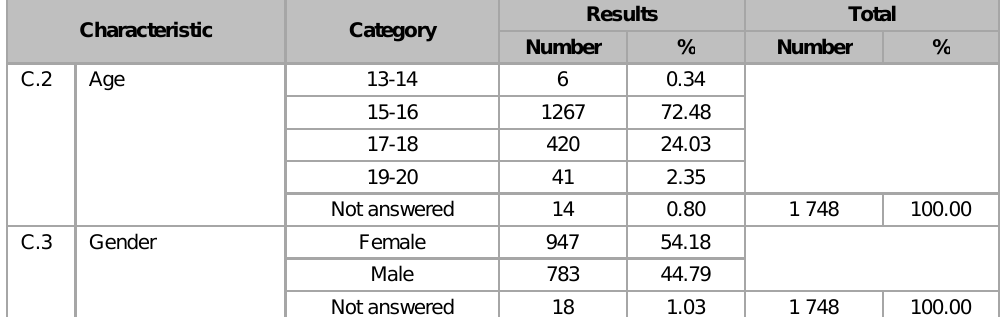
Demographic profile of the Sedibeng sample ( n = 1